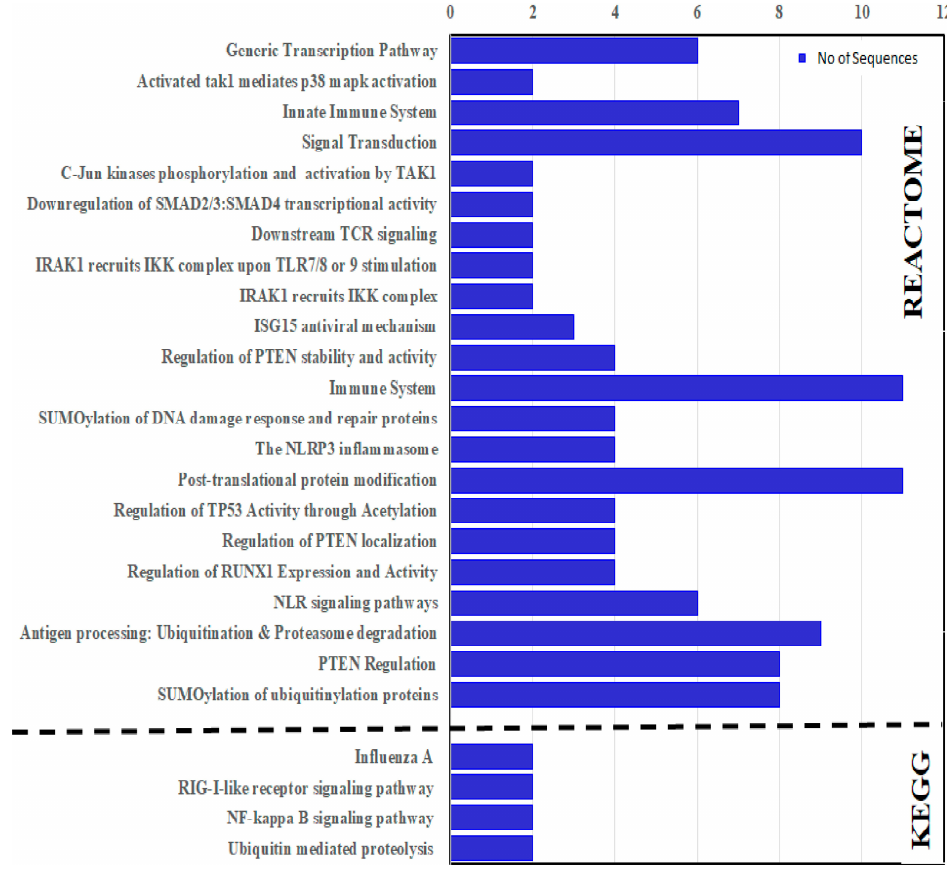
Figure 10. KEGG and Reactome enrichment analysis of TRIM proteins from common carp specie.